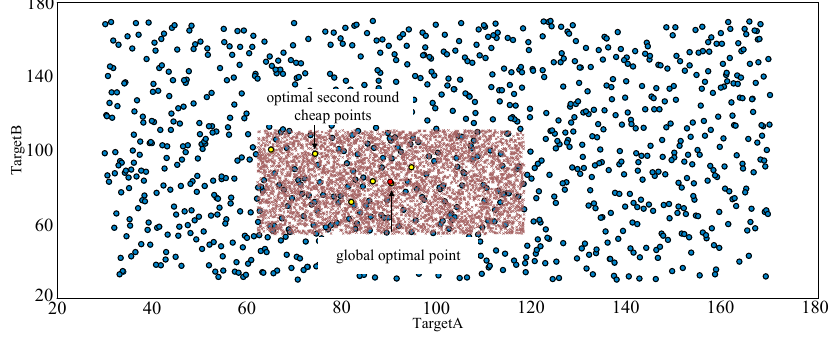
Figure 13. Second round cheap points.